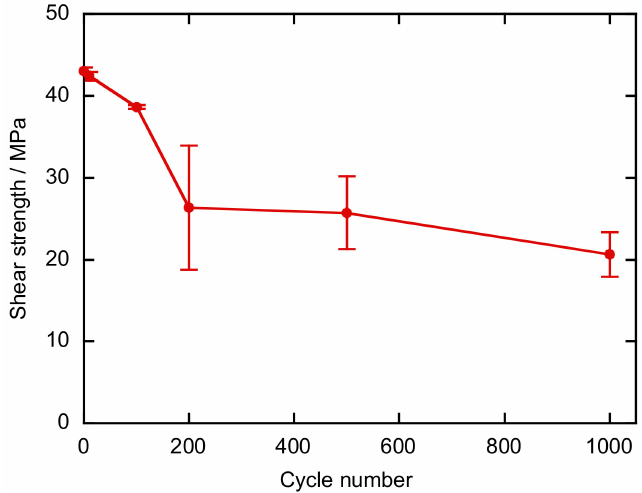
Figure 10. Variation in shear strength during heat shock test.